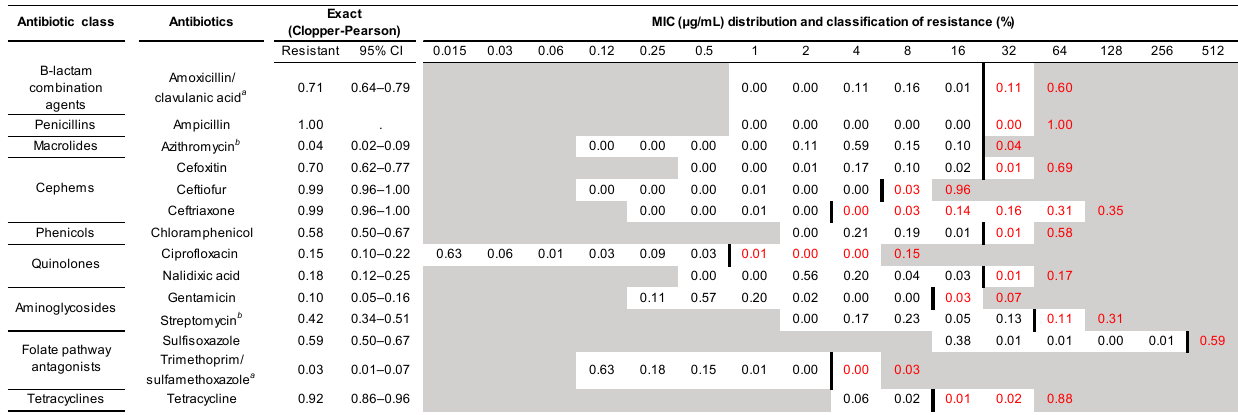
Figure 3. Proportions and 95% confidence intervals of bacterial phenotypic resistance and corre- sponding MIC distributions for 142 ESBL or AmpC E. coli isolates tested against 14 antibiotics. The shaded areas represent the out-of-dilution ranges for antibiotics on the plate. Therefore, numbers in the shaded areas represent right-censored MIC resistant values. The proportion of resistant isolates is indicated in red, and breakpoints for resistant classification are shown as bolded lines between the black and red numbers. a MIC of the first antibiotic in a combination is listed. b NARMS consen- sus breakpoints were used for the classification of resistance.